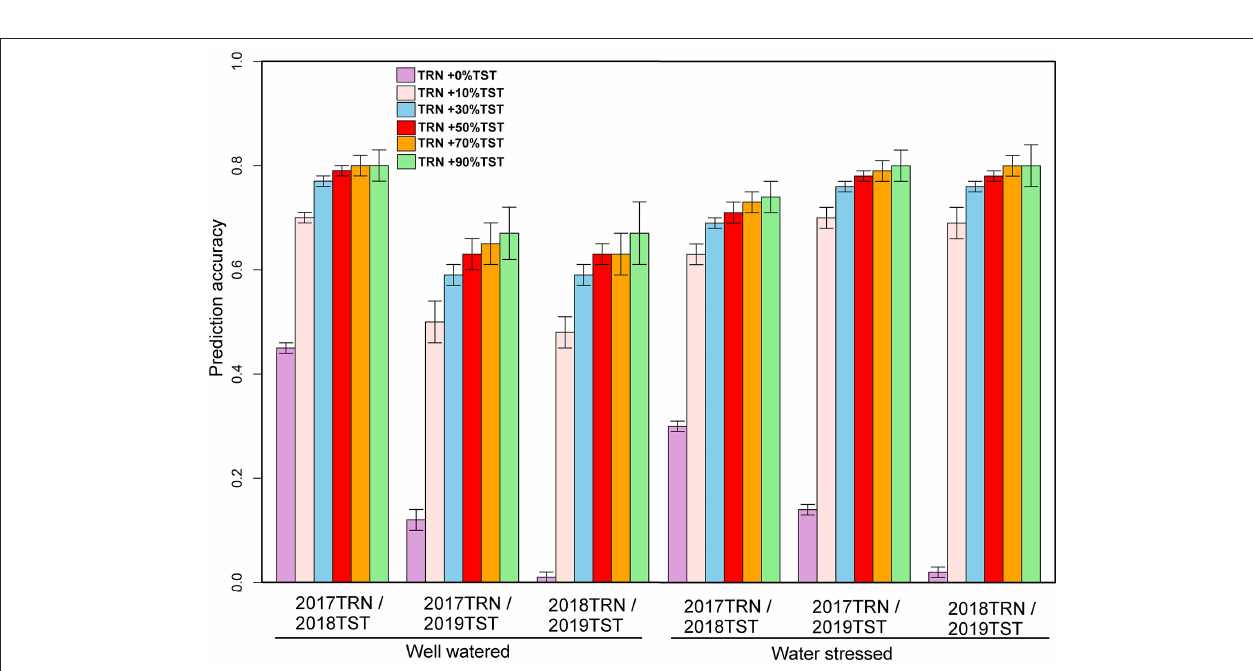
FIGURE 4 | Prediction accuracies for plant height estimated from independent validation schemes using 1-year data to predict another year’s data and converting 10, 30, 50, 70, and 90% of the data from the testing population to the training population under optimum and managed drought conditions.